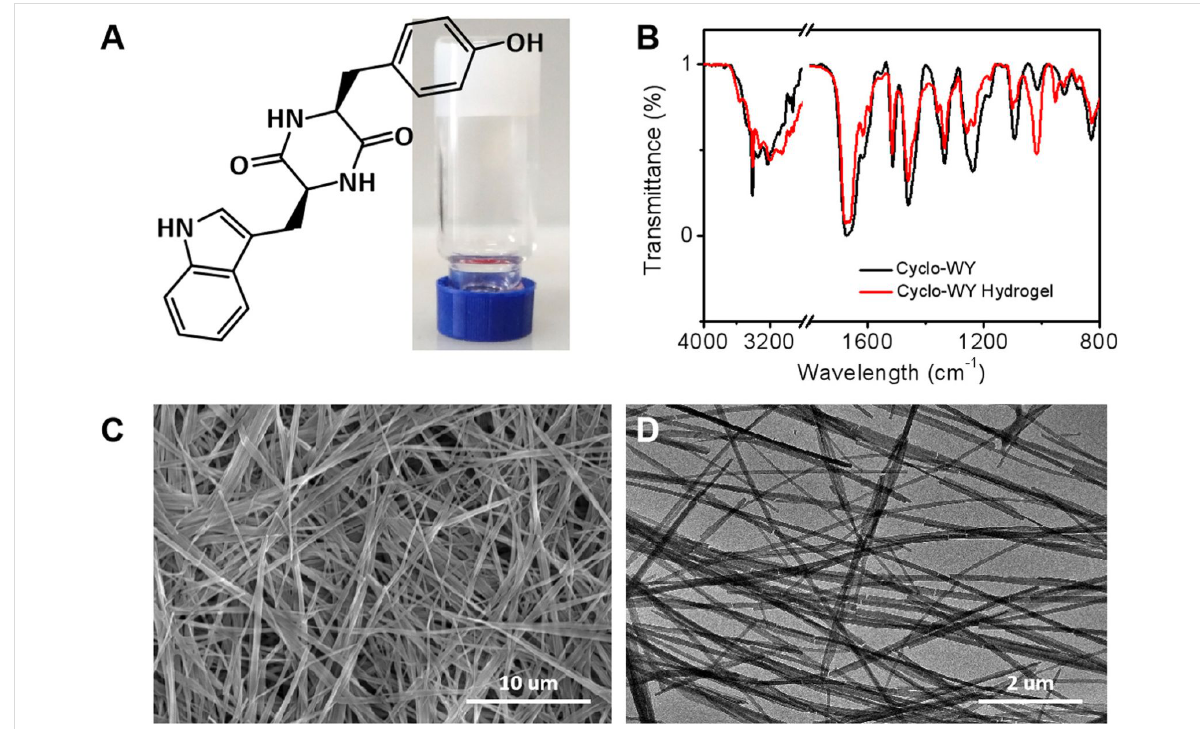
Figure 1: CDP-based supramolecular hydrogels. (A) The structure of C-WY and a photo of the C-WY hydrogel. (B) FTIR spectra of C-WY powder and the C-WY hydrogel. (C) SEM and (D) TEM images of the C-WY hydrogel.